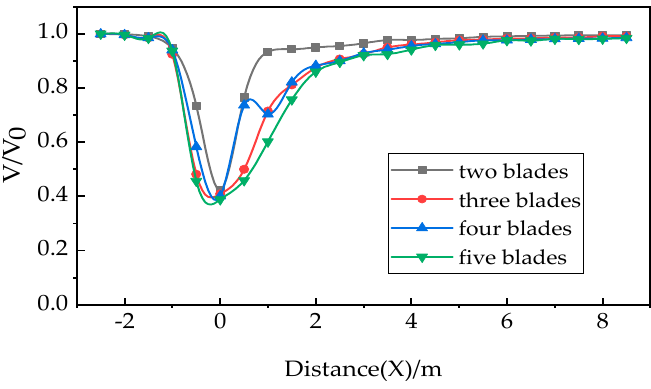
Figure 13. Relative velocity comparison curve when the number of blades is two, three, four and five.